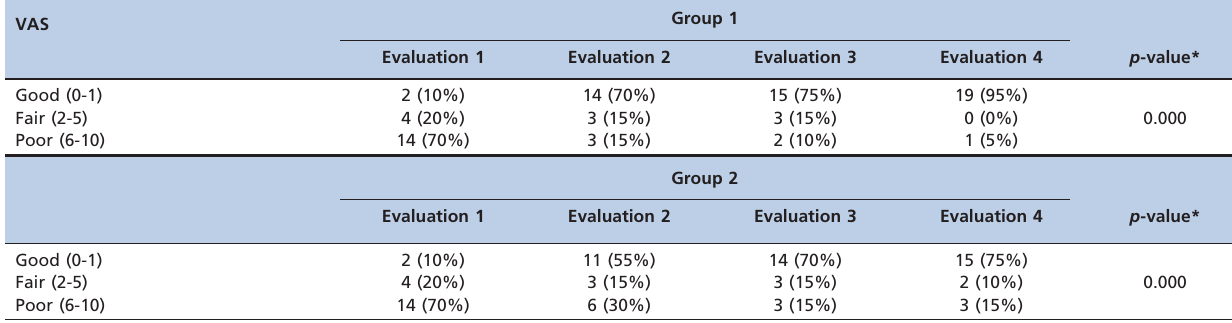
Table 3 - Distribution of intensity of gait pain in groups 1 and 2 before and after the treatment (immediately, three months and one year after the